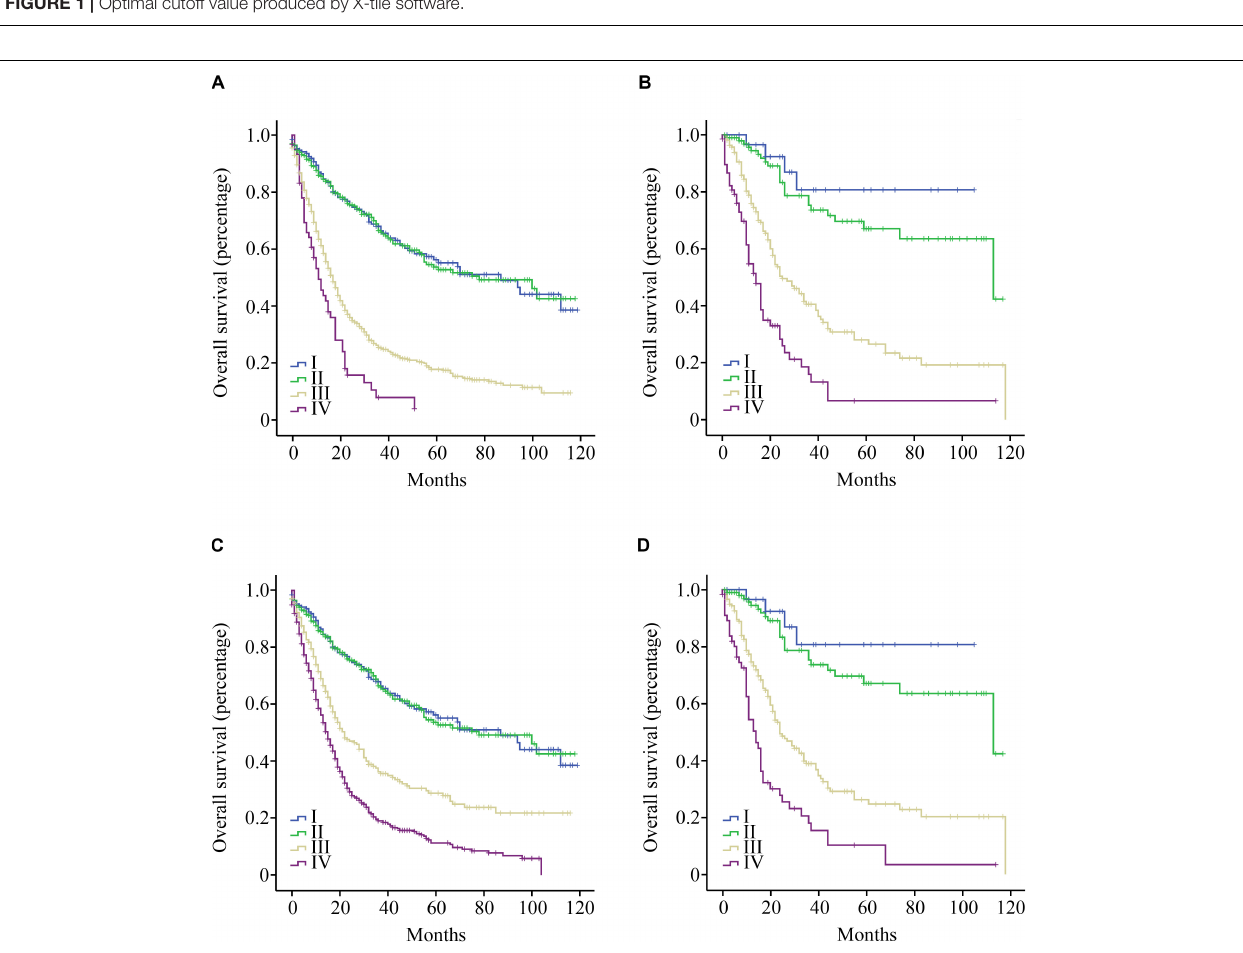
FIGURE 2 | Overall survival curves for patients with GBC by LN count. (A) Patients with fewer than six LNs examined according to the TNM staging system; (B) Patients with six or more LNs examined according to the TNM staging system; (C) Patients with fewer than six LNs examined according to the TNrM staging system; and (D) Patients with six or more LNs examined according to the TNrM staging system.